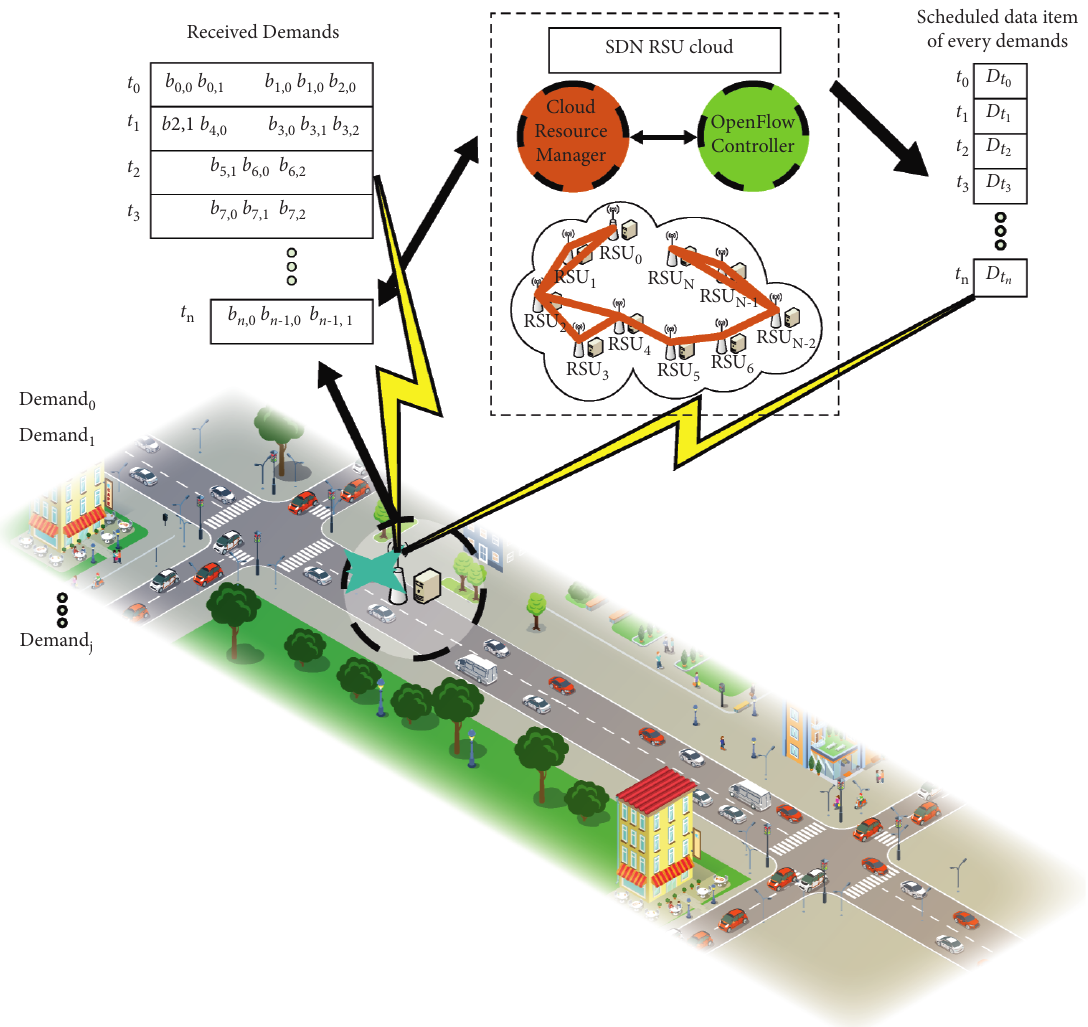
Figure 2: The mechanism of the proposed SDN RSU